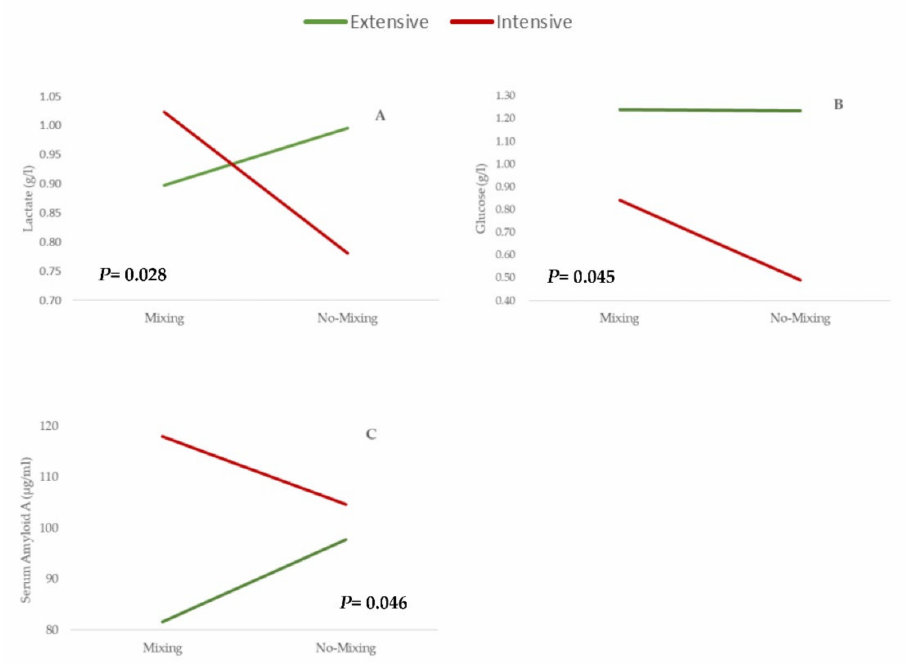
Figure 2. Interaction farm management system x pre-slaughter handling at slaughtering time (Ts) on ( A ) lactate, ( B ) glucose and ( C ) serum amyloid A. Mixing ( n = 40); no-Mixing ( n =